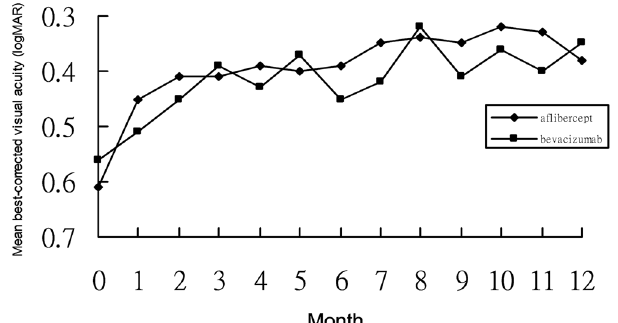
Figure 1. Changes of best-corrected visual acuity from baseline to month 12 in patients with myopic choroidal neovascularization treated by intravitreal aflibercept or bevacizumab.